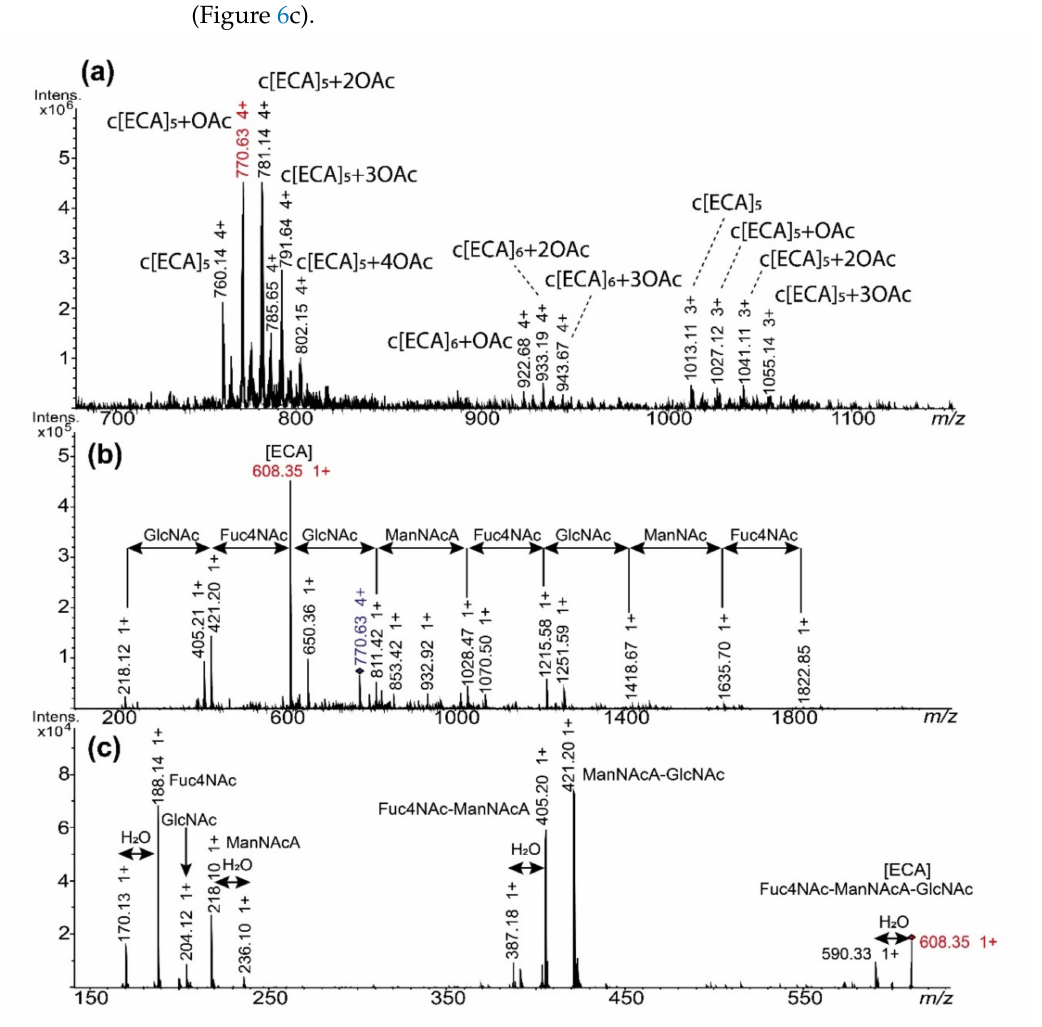
Figure 5. ESI-MS n fragmentation analysis of c[ECA] 5 isolated from E. coli R1 LPS supernatant. Spectra were acquired in positive-ion mode on ESI-IT mass spectrometer. ( a ) The MS spectrum of the fraction II; ( b ) The MS 2 of the ion at m / z 770.63 (4+) ion corresponding to the c[ECA] 5 − OAc; ( c ) The MS 3 of the ion at m / z 608.35 (1+) corresponding to one ECA repeating unit and resulted from the fragmentation of m / z 770.63 → 608.35. m / z values marked in red correspond to ions selected for MS n fragmentation. GlcNAc, ManNAcA, and Fuc4NAc stand for ECA constituents; H 2 O stands for mass difference attributed to water